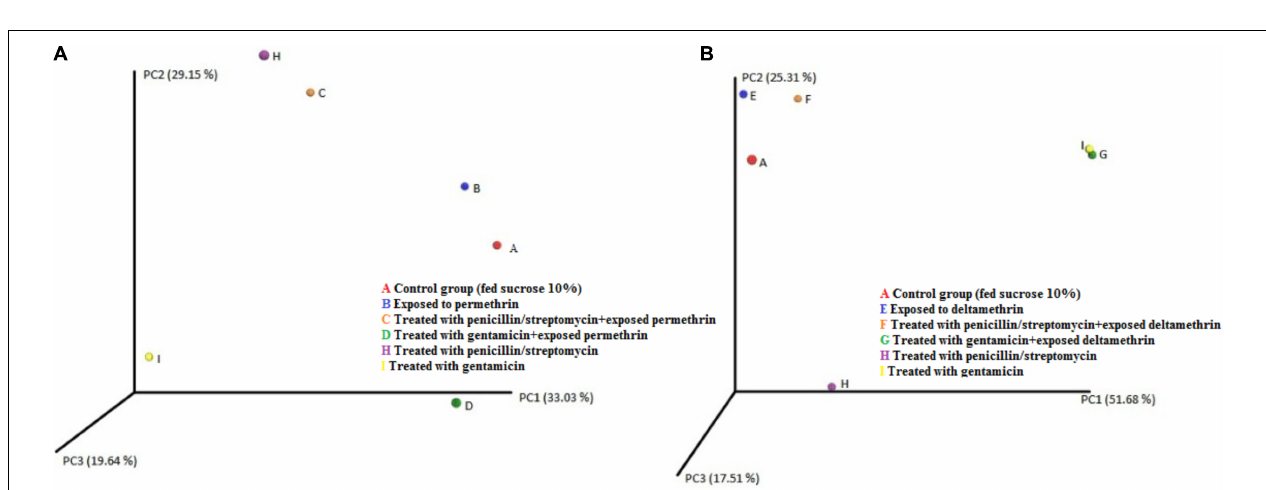
FIGURE 4 | Abundance heatmap of taxa with simple clustering (species) of bacterial communities of A. aegypti mosquitoes with permethrin exposure after microbiome suppression. A: fed with sucrose 10%, B: exposed to permethrin (control group), C: treated with penicillin/streptomycin permethrin exposed, D: treated with gentamicin permethrin exposed, H: treated with penicillin/streptomycin (not exposed), I: treated with gentamicin (not exposed).